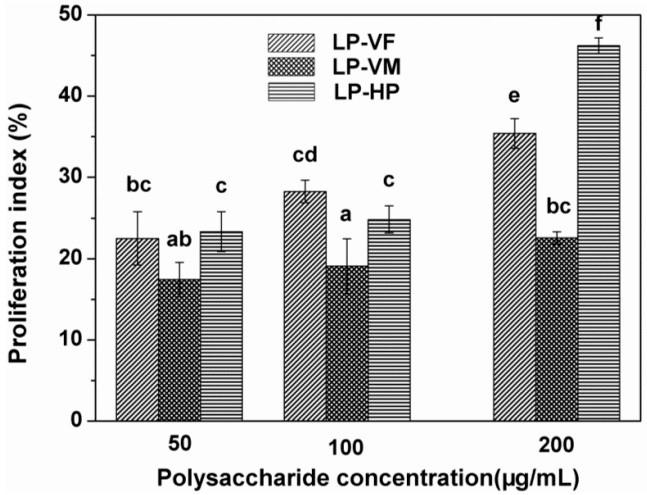
Figure 3. Effects of litchi polysaccharide-protein complexes on the proliferation index of splenocytes at different concentrations (50, 100 and 200 μg/mL). The proliferation indexes were assessed by the MTT assay and expressed as the mean ± standard deviation ( n = 6). Bars labeled with different letters represent a statistical difference at p < 0.05. LP-VF: Litchi polysaccharide-protein complexes from vacuum freeze dried pulp; LP-VM: Litchi polysaccharide-protein complexes from vacuum microwave dried pulp; LP-HP: Litchi polysaccharide-protein complexes from heat pump dried